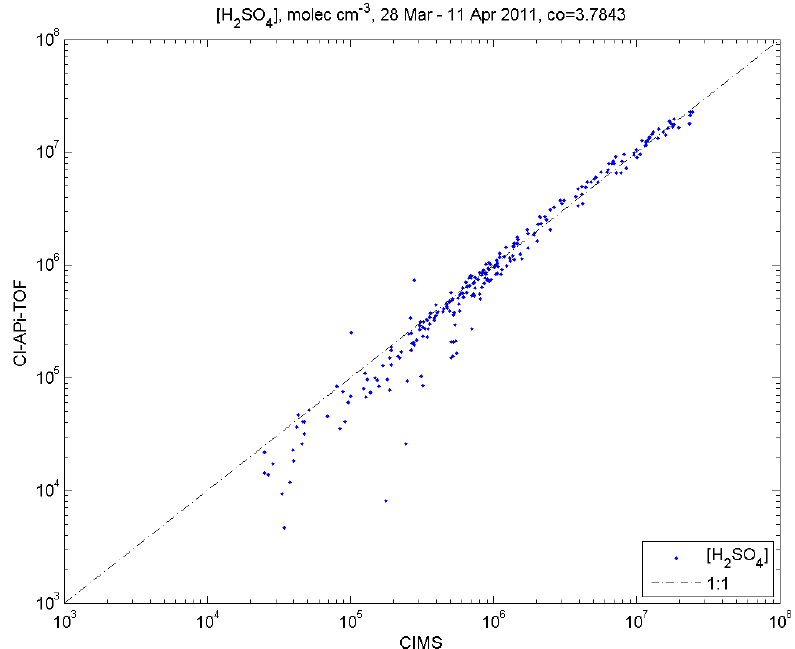
Fig. 1. Correlation between sulphuric acid concentrations measured with the CI-APi-TOF (using a standard calibration coefficient C = 5 × 10 9 , Mauldin III et al., 1999) and calibrated CIMS from 28 March to 11 April 2011. Data sets are 60min averages. The CI-APi-TOF data have been multiplied by the average ratio between the two data sets, 3.78. This factor includes diffusion losses in the CI-APi-TOF sample line, and is used when converting the CI-APi-TOF signals to